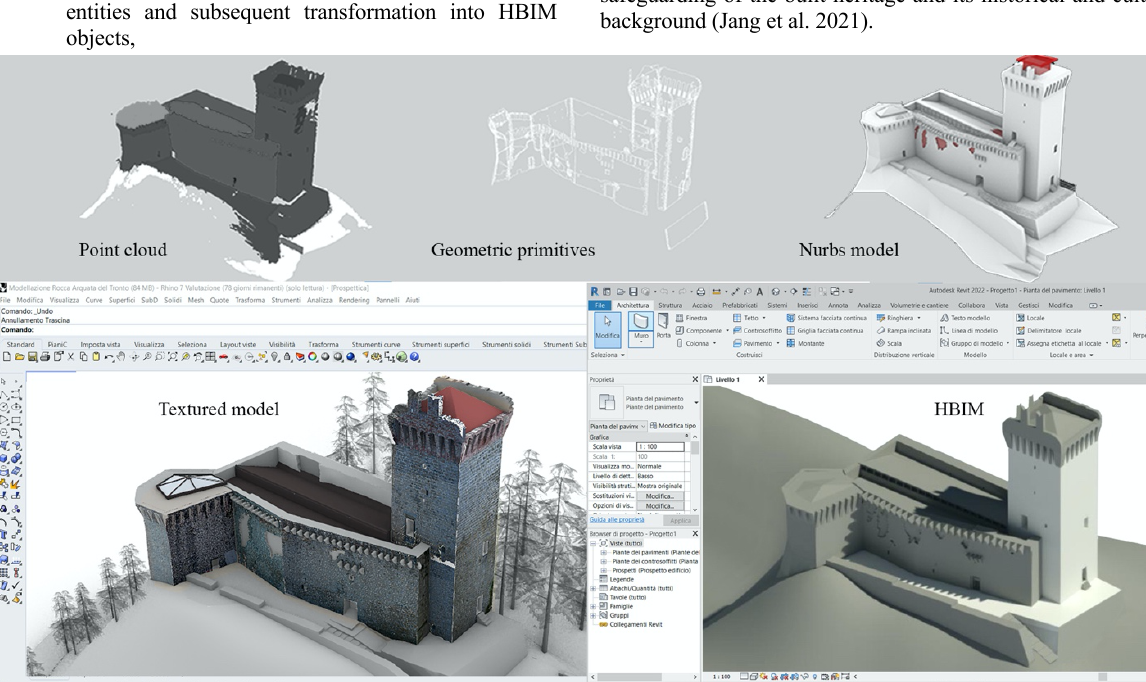
Figure 10. The HBIM Model of the of the